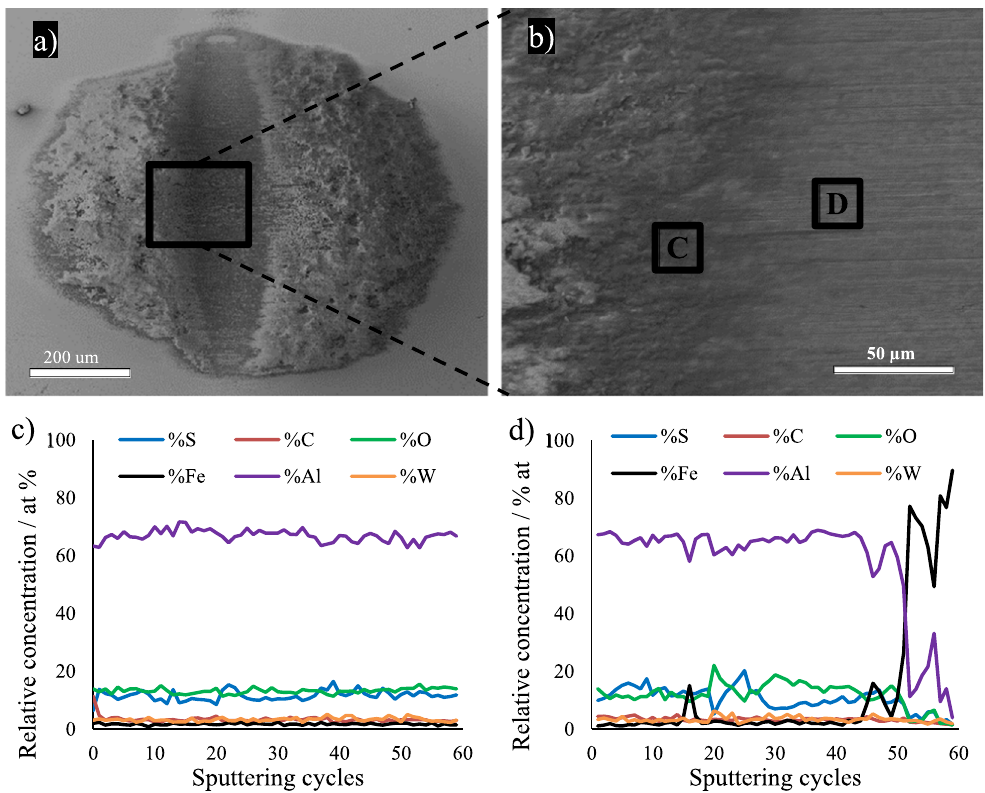
Figure 13. ( a , b ) SEM images of the wear scar on the ball tested against the IF-WS 2 composite at 100 °C; ( c , d ) Auger ion sputtering depth profile of the chemical composition in points C and D of the